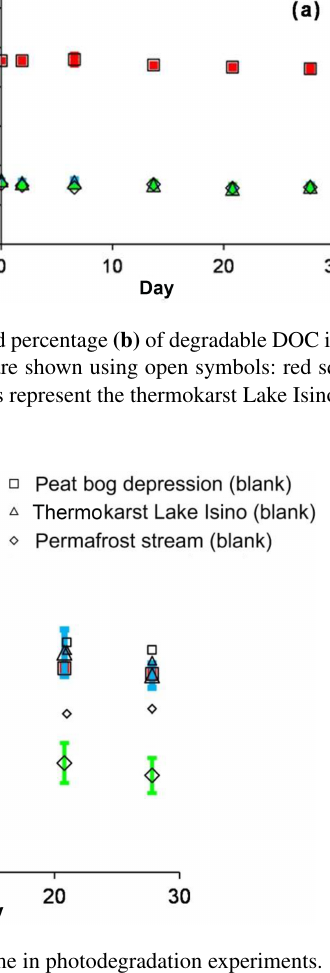
Figure 4. SUVA 254nm over time in photodegradation experiments. The error bars are ± 1SD of the